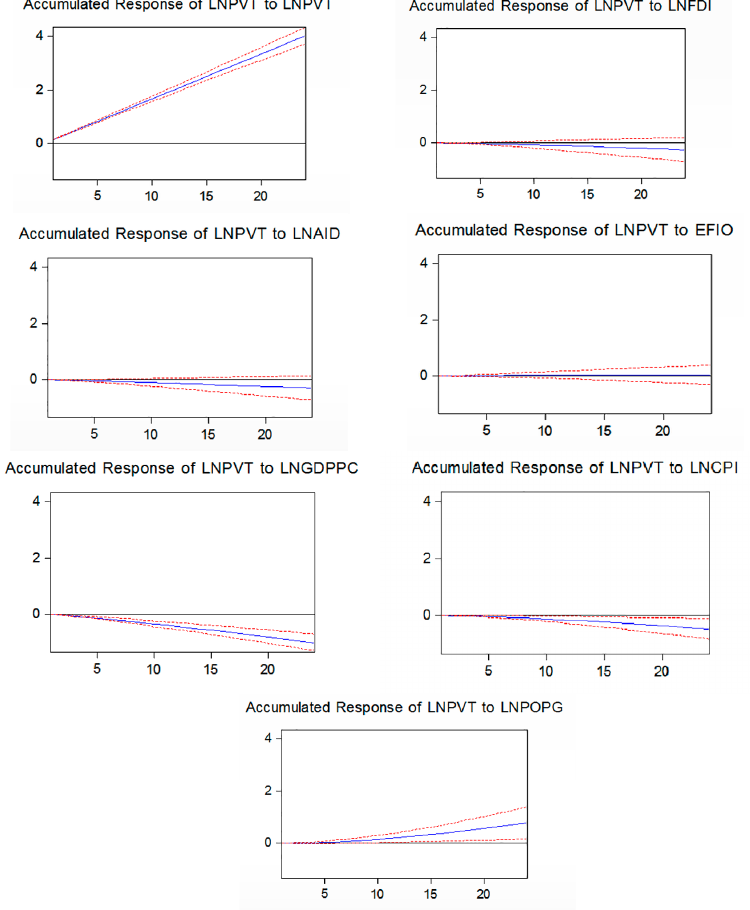
Figure 1. Impulse response function of poverty alleviation to the exogenous